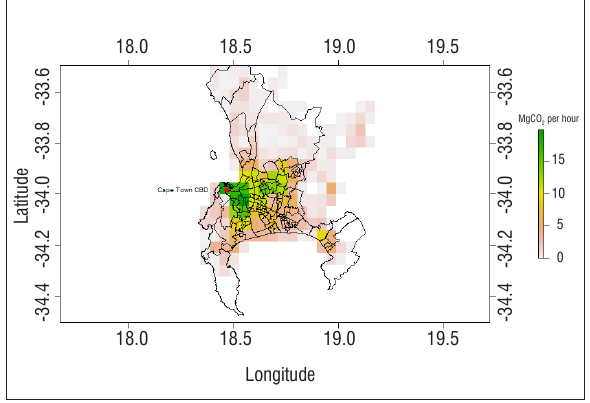
Map of rasterised CO vehicle emissions during peak hour 2 traffic, produced from vehicle kilometre hours and an average emission